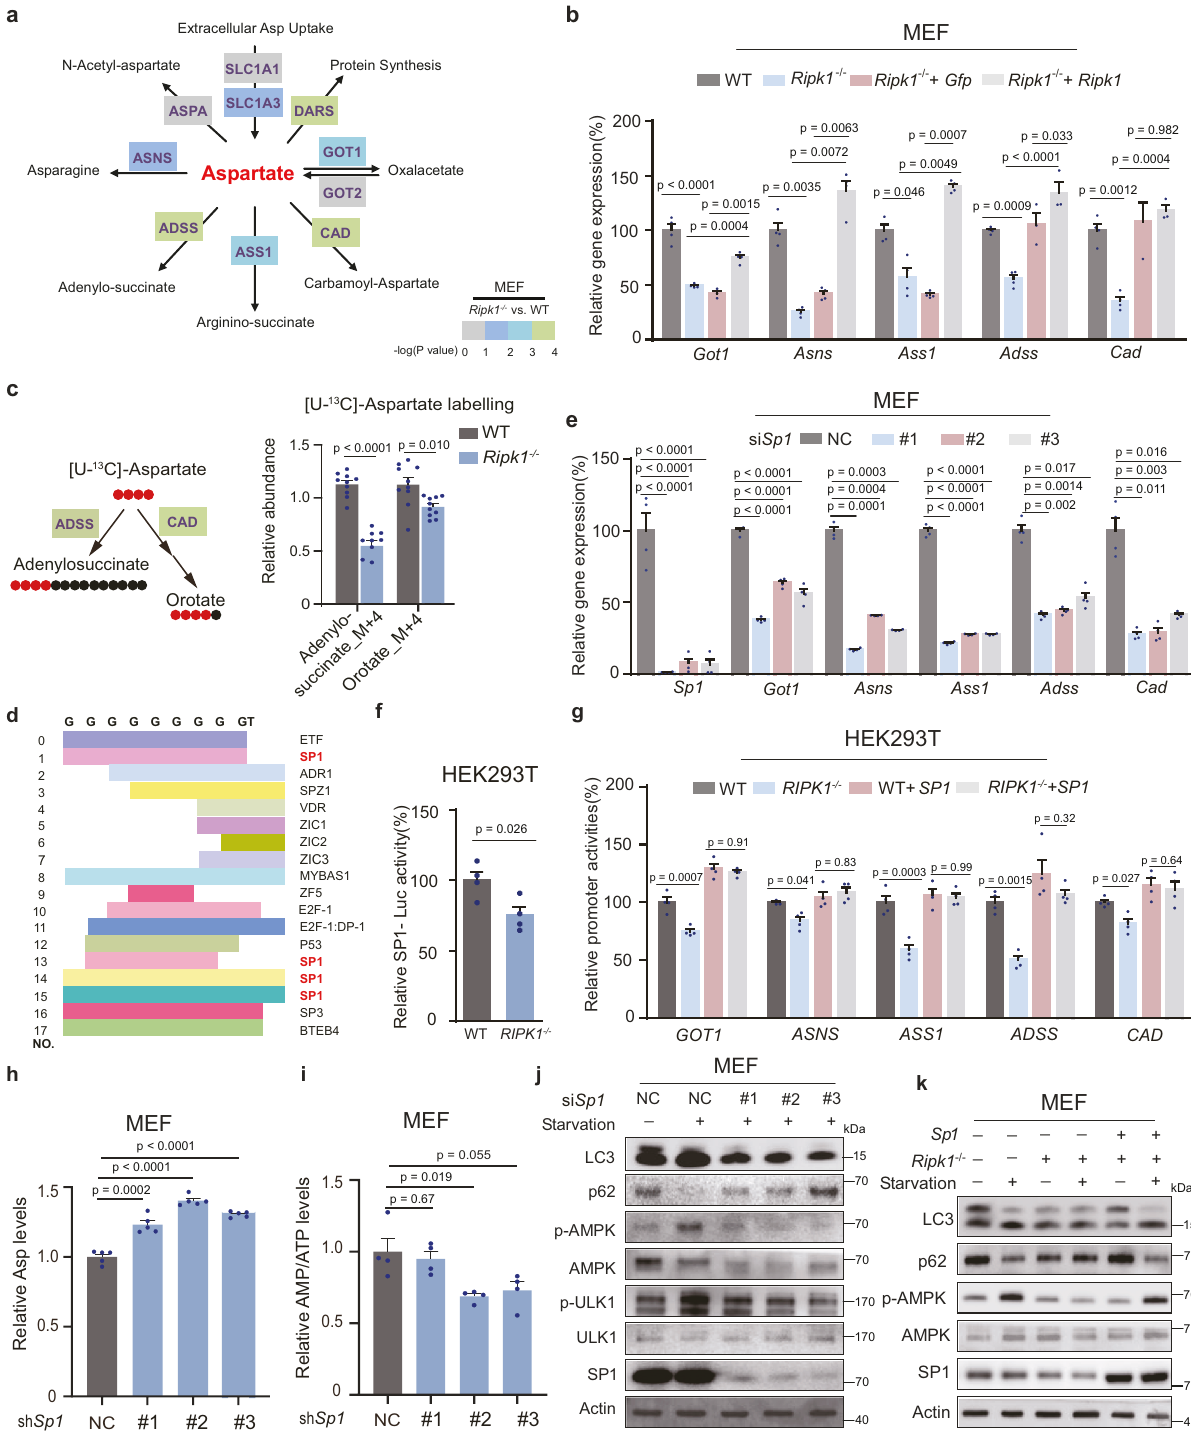
Supplementary Table 5; antibody names and catalog numbers are described in Supplementary Table 6. Mice . Mice (C57BL/6) were group-housed in a barrier facility at room tempera- tures of 20 – 26°C with 40 – 70% humidity and 12 h light/12 h dark cycles. All mice received a regular chow diet ad libitum. All animal care and experiments were conducted in accordance with the Institutional Animal Care and Use Committees of Interdisciplinary Research Center on Biology and Chemistry, Shanghai Institute of Organic Chemistry, Chinese Academy of Sciences.